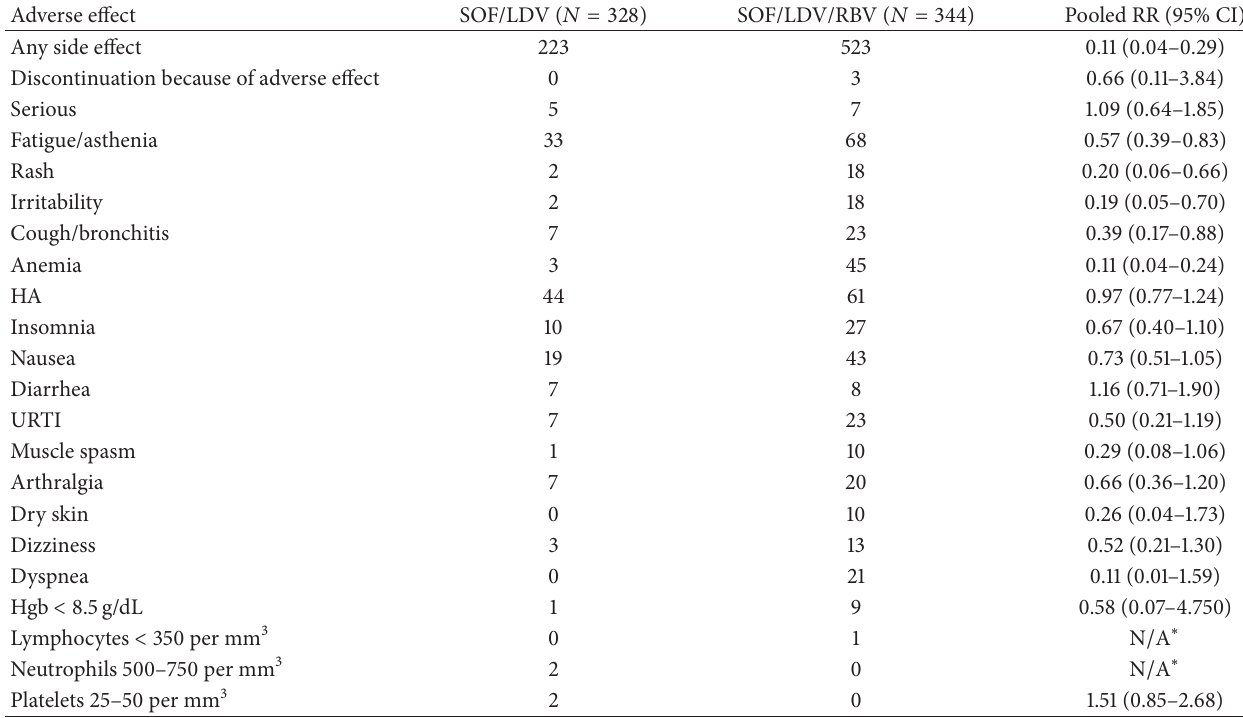
Table 3: Combined adverse events for SOF/LDV and SOF/LDV/RBV and their associated pooled relative risks, with SOF/LDV/RBV as the reference group.